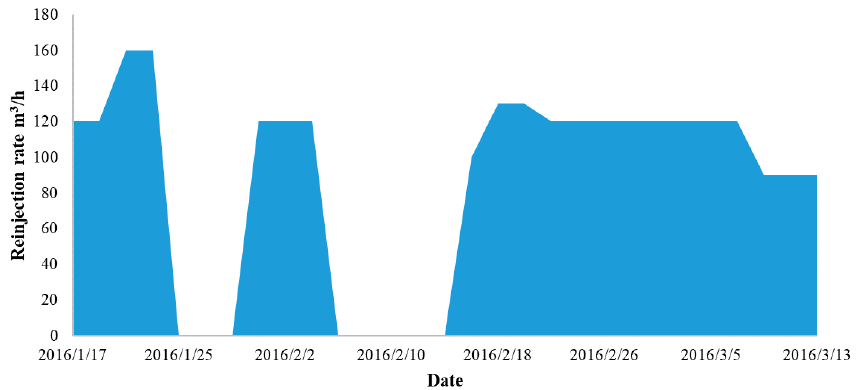
Figure 1. Reinjection rate of Xinji oil production well no. 5.